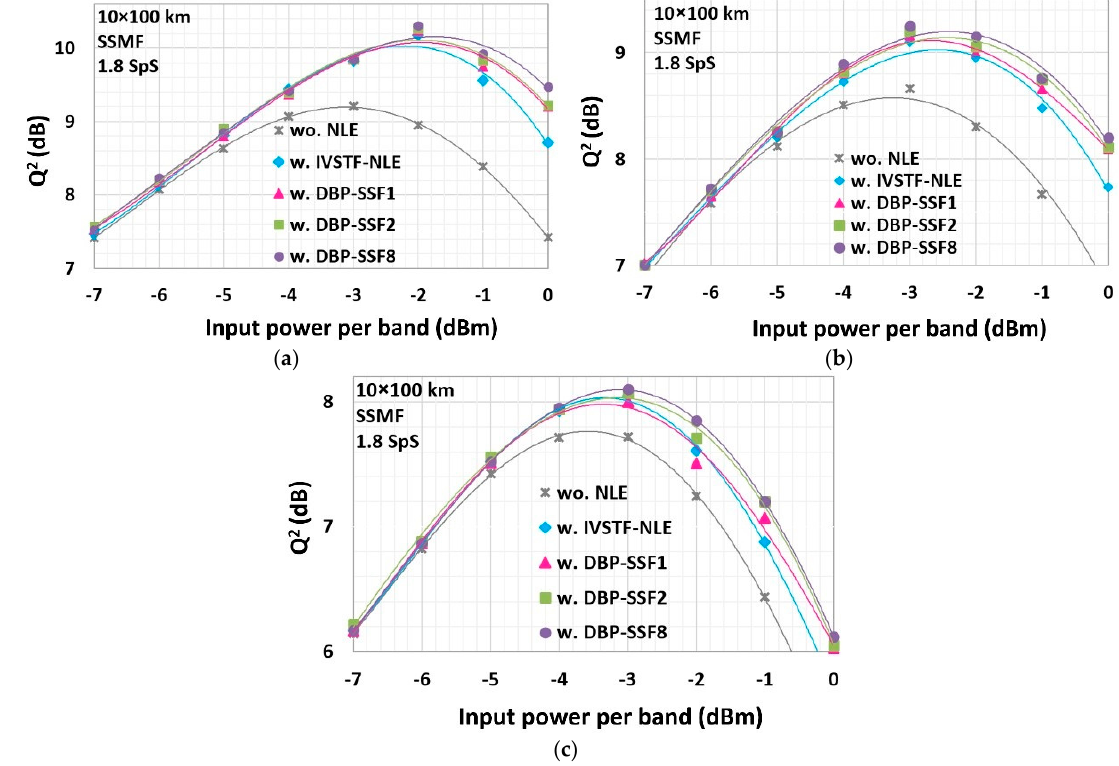
Figure 5. Experimental results on Q 2 -factor vs. input power per band without/with IVSTF-NLE and DBP-SSF 1,2,8 in ( a ) single-channel with a single OFDM band; ( b ) a single-OFDM-band super-channel surrounded by WDM DP-QPSK channels; and ( c ) a WDM, 4-band OFDM super-channel surrounded by WDM DP-QPSK channels after transmission through 10 × 100 km SSMF.